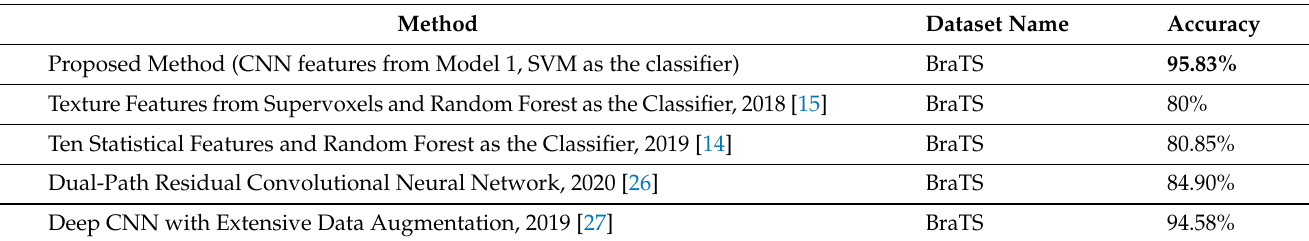
Table 3. Comparison of the proposed method for Glioma Tumor Classification with the latest literature techniques.